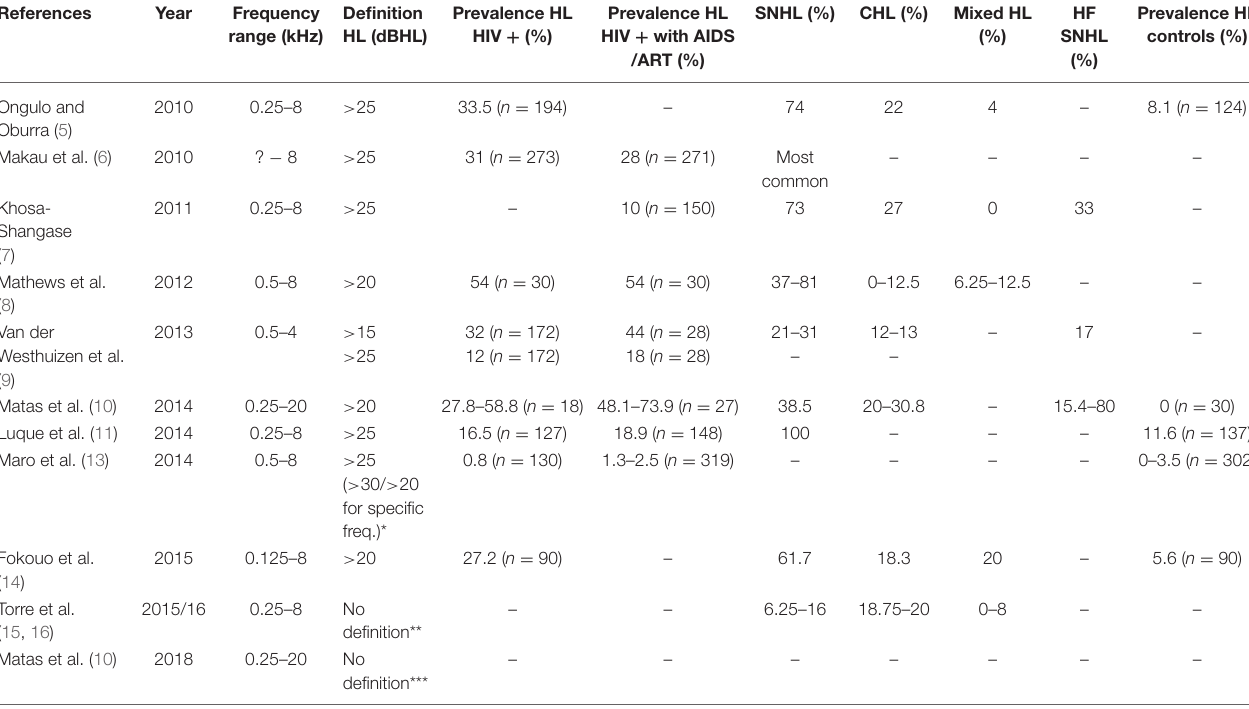
TABLE 2 | Overview of Pure Tone Audiometry results—prevalence and type of hearing